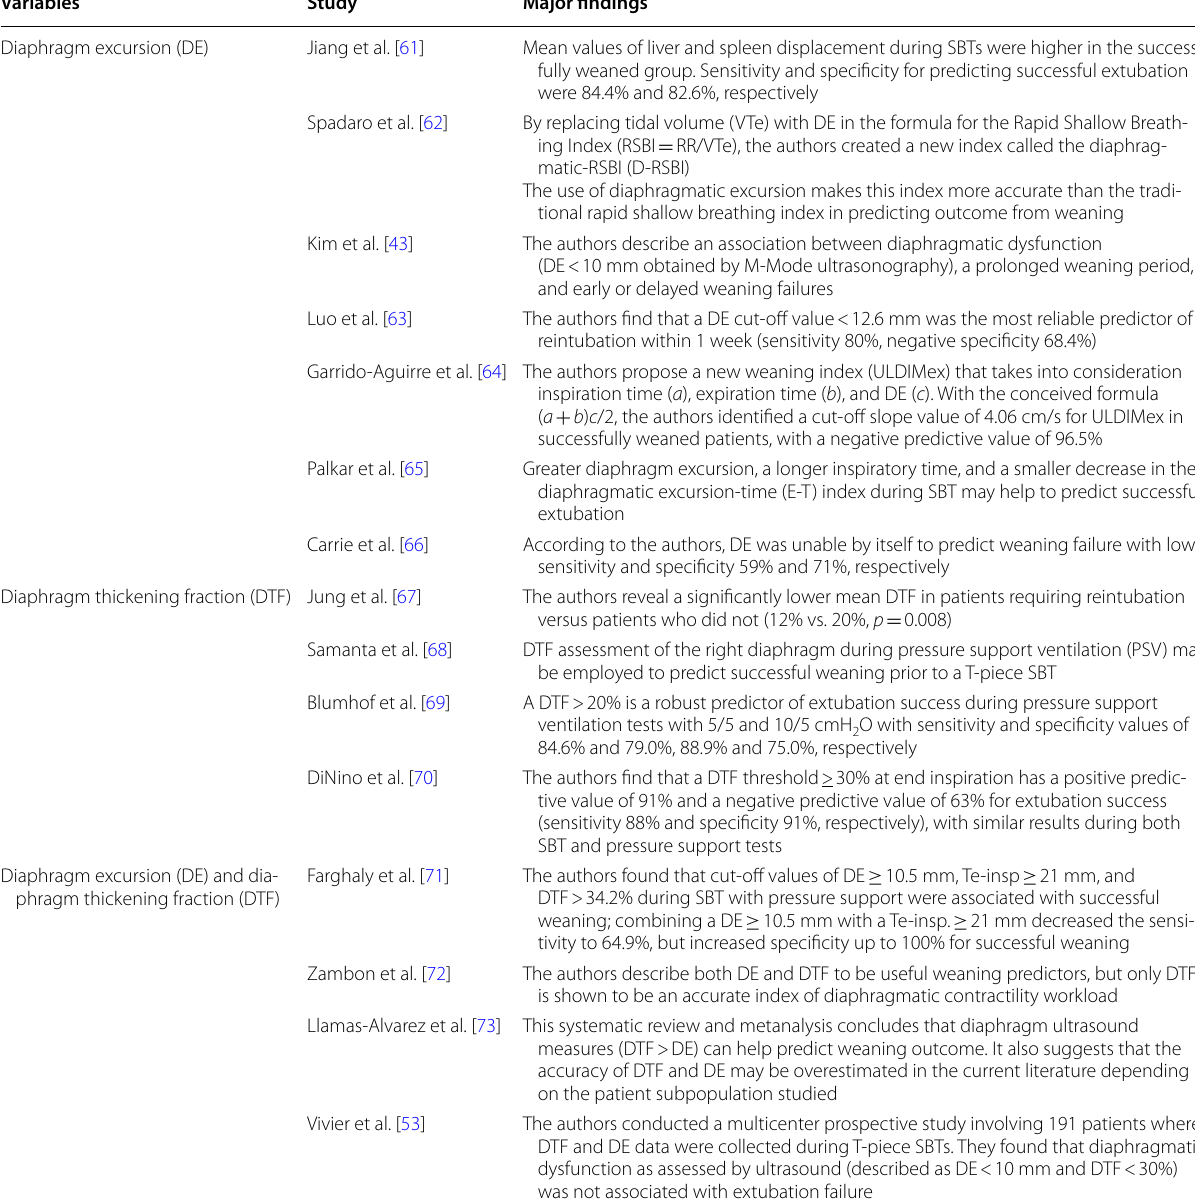
DUS diaphragm ultrasound, DE diaphragm excursion, DTF diaphragm thickening fraction, SBT spontaneous breathing trial, Te-insp. end-inspiratory thickness